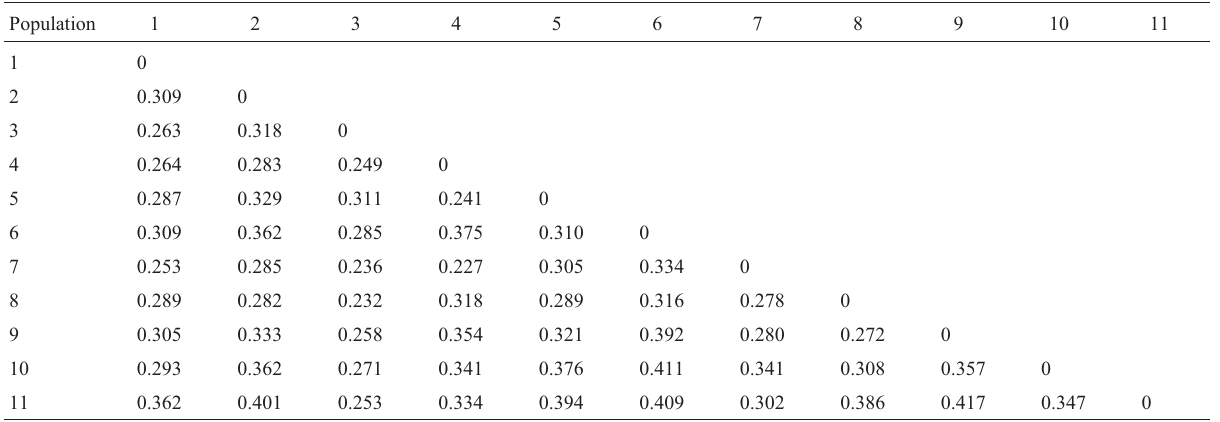
Table 5 - Matrix of Φ ST values for each pairwise combination of 11 Eupemphix nattereri populations based on 82 random amplified polymorphic DNA (RAPD) loci. Population